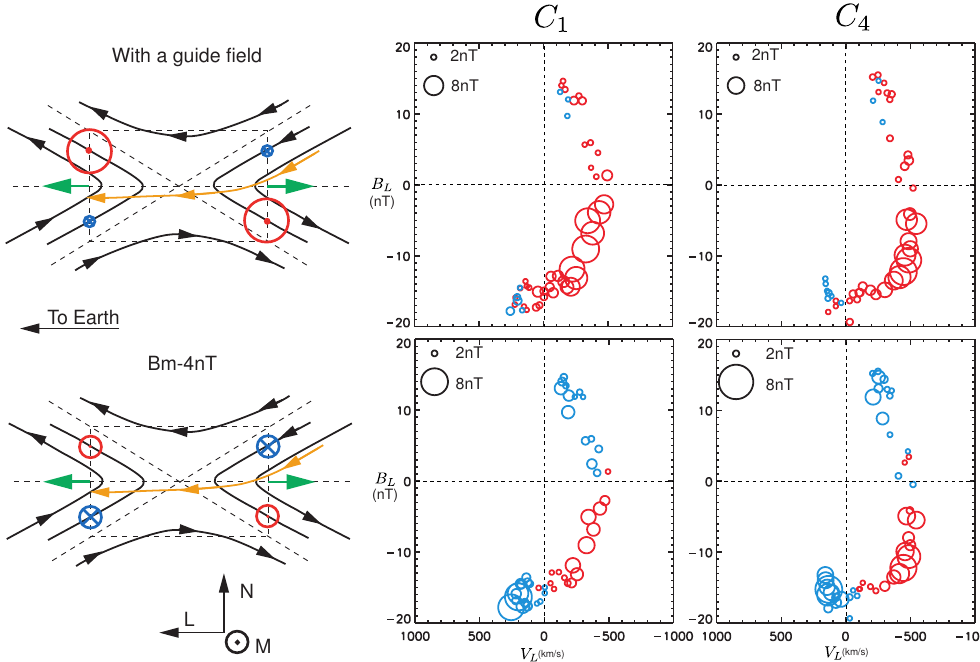
Fig. 3. Left: cartoons representing the reconnection plane, magnetic field lines in black, blue and red circles represent the out-of-plane negative and positive component of the magnetic field, respectively. Green arrows represent the plasma jets and the yellow curve is the possible trajectory of the Cluster spacecraft. Right: scatter plot of the out-of-plane component of the magnetic field represented as colored circles in the (V L ,B L ) plane. As for the cartoon on the left, the size of the circle represents the amplitude of the field. Blue and red circles code negative and positive values, respectively. Lower panels represent the same data as upper panel but where 4nT has been subtracted from the out-of-plane magnetic component.